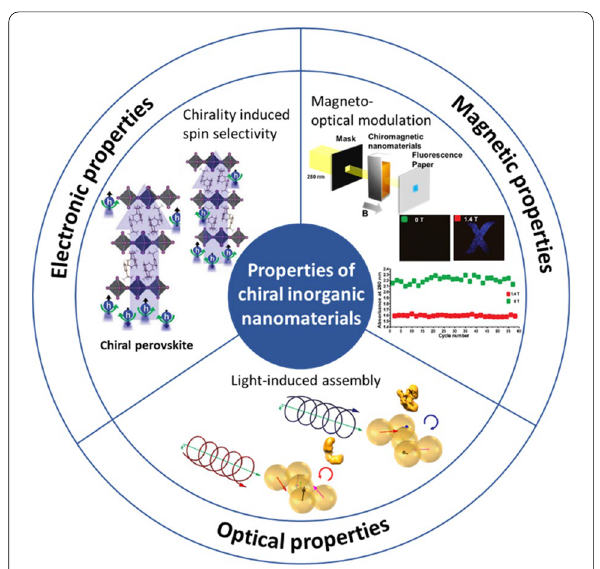
Fig. 2 Representative chiral NMs with different properties composed with pictures from [9, 14, 17,